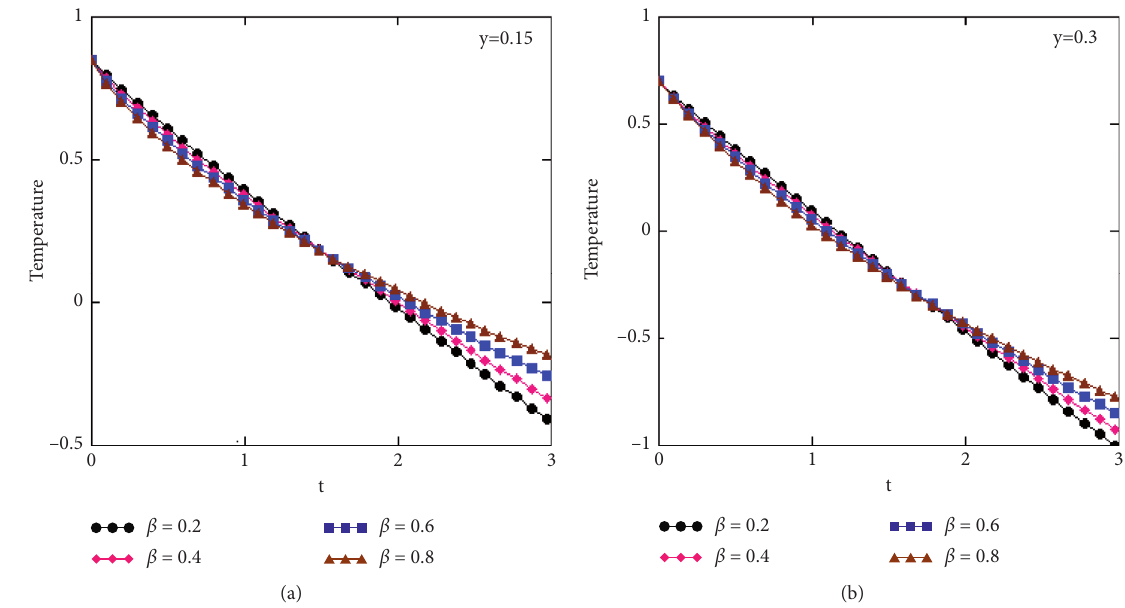
Figure 6: Profiles of dimensionless temperature verses t for β at two values of y for Pr � 20 ,Q � 0 . 5, and f